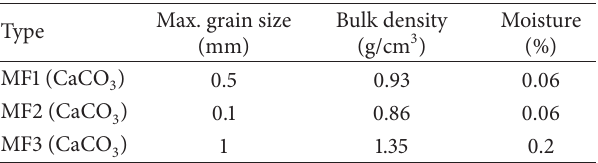
Figure 4: Natural basalt aggregate gradation. Table 2: Physical properties and chemical composition of the three microfillers